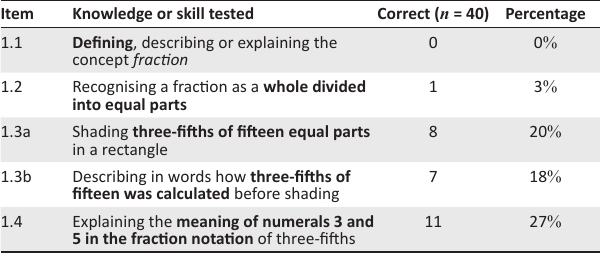
TABLE 2: Correct learner solutions per test item.